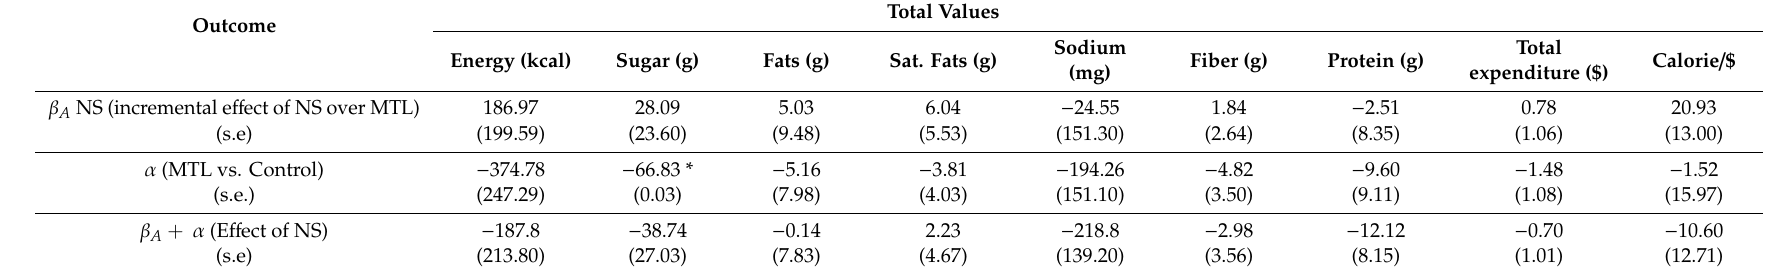
Table A6. Regression for beverages only with total values and cost as outcome ( N = 190, n = 111).